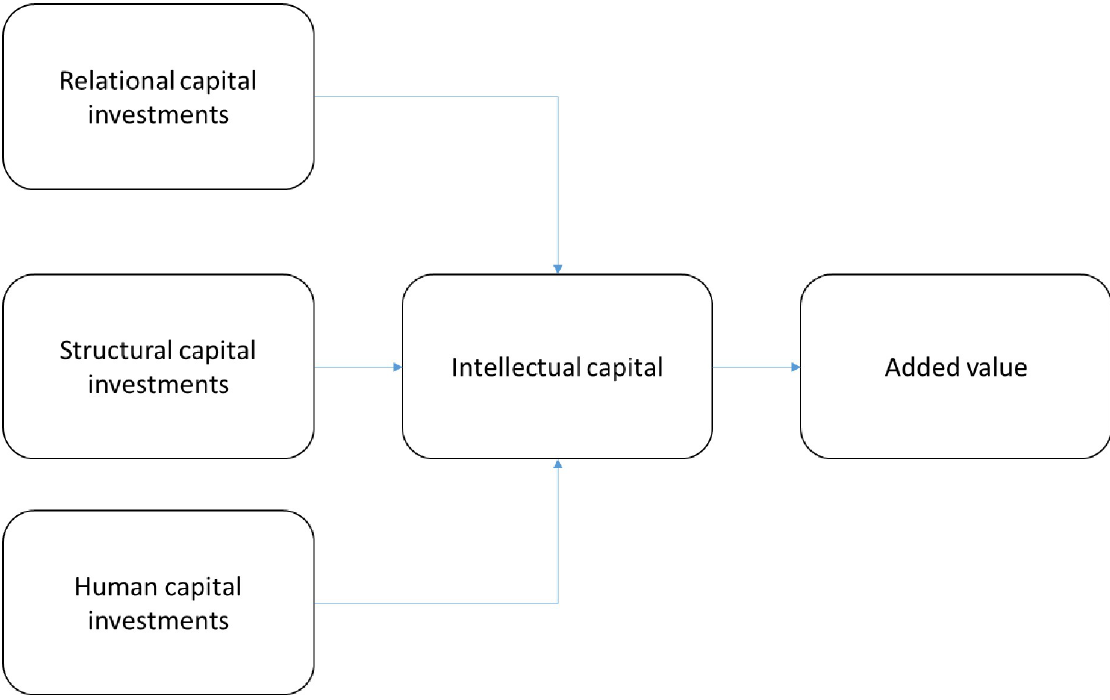
Fig 1. Model estimation of intellectual capital.